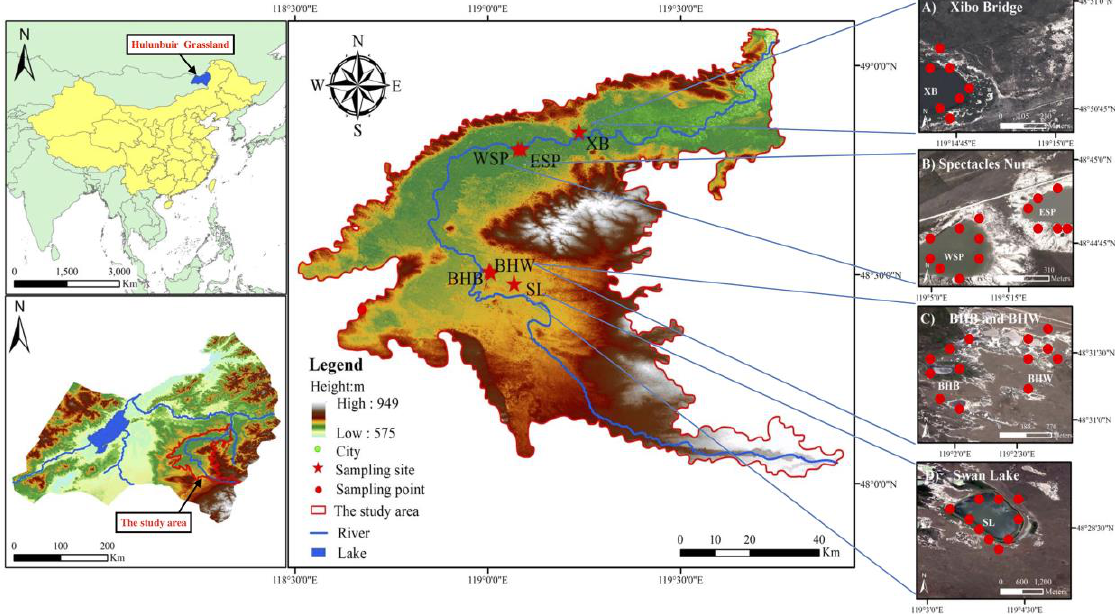
Figure 2. Location of sampling sites along the Hui River Basin of the Hulunbuir Grassland.